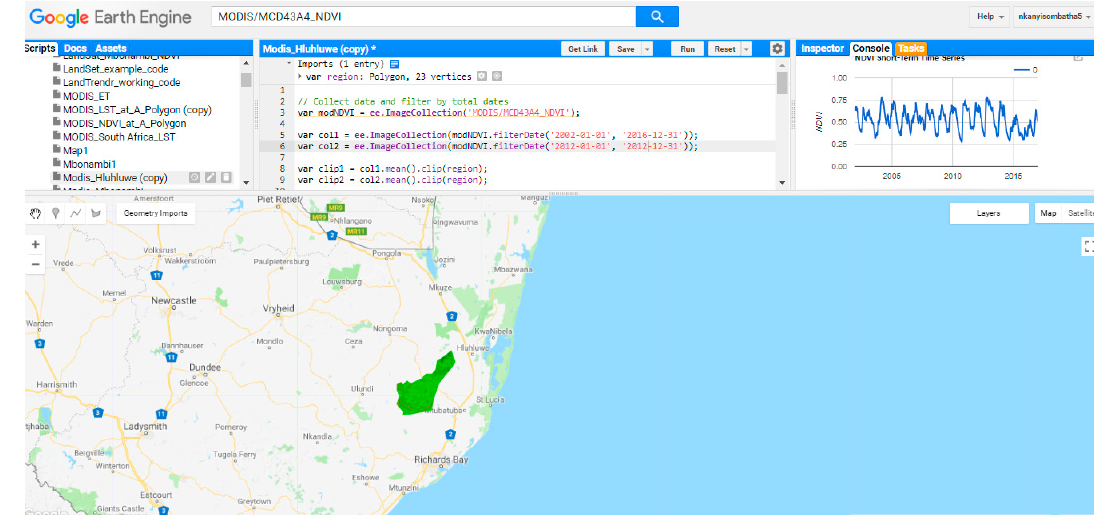
Figure A1. The Google Earth Engine interactive development environment.